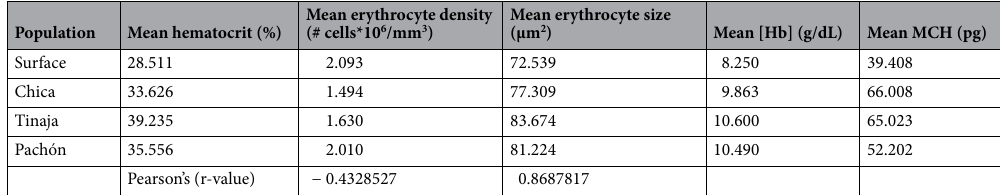
Table 1. Population-level blood parameters used to perform Pearson’s correlations and calculate mean corpuscular hemoglobin. [Hb] hemoglobin concentration, MCH mean corpuscular hemoglobin.